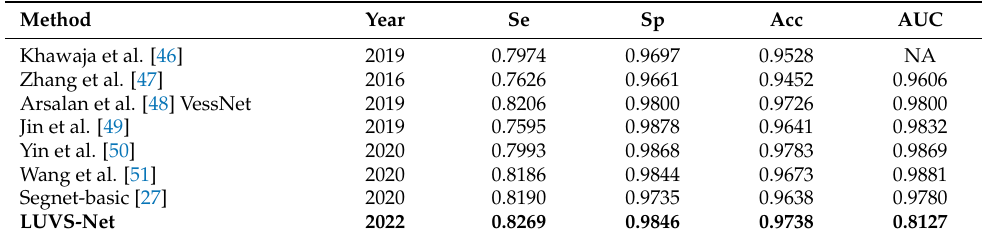
Table 5. LUVS-Net compared to existing models as tested (dataset: CHASE_DB1).